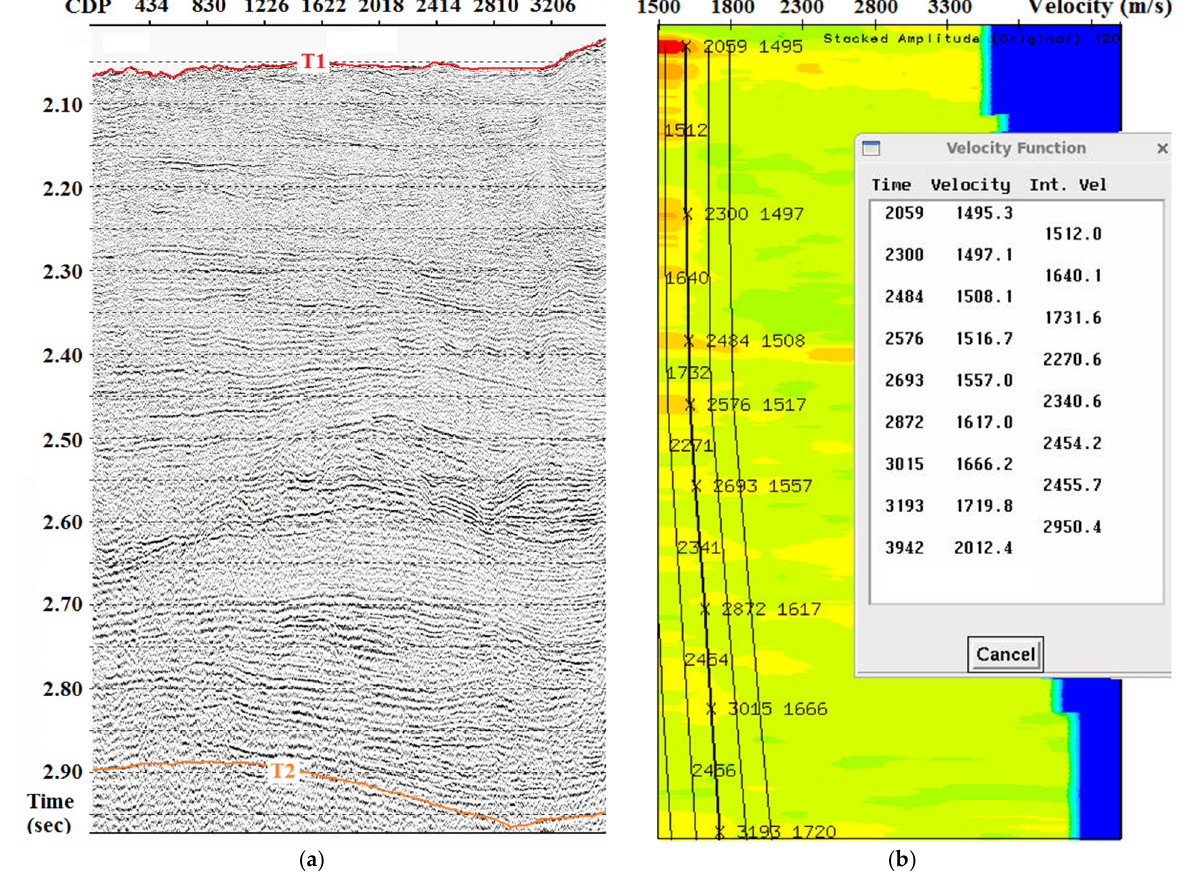
Figure 7. Seismic profiles obtained in deep water north of the South China Sea ( a ) Seismic profile; ( b ) Velocity spectrum.